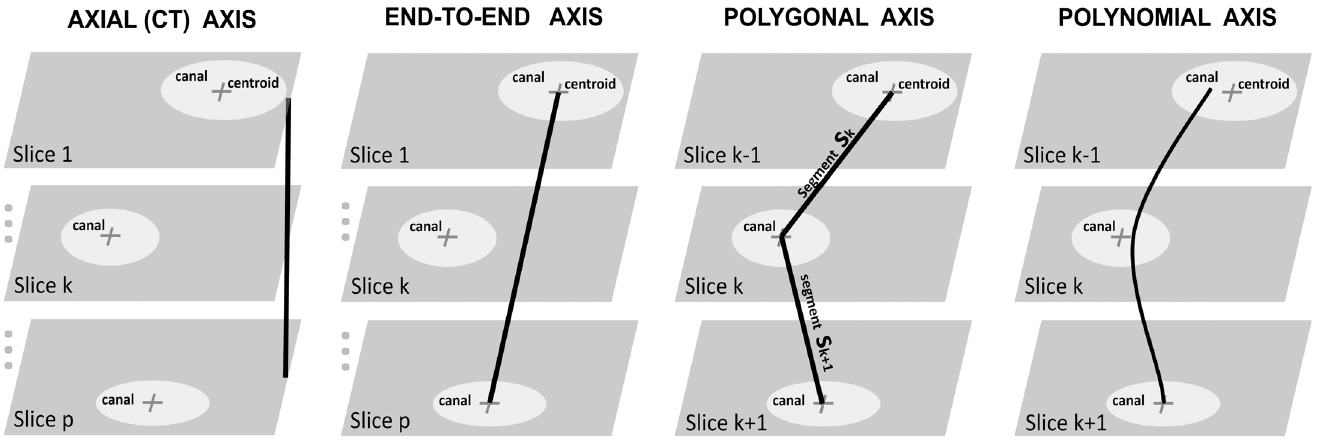
Fig 2. Depiction of the four methods to compute NLC length: axial, end-to-end, polygonal,